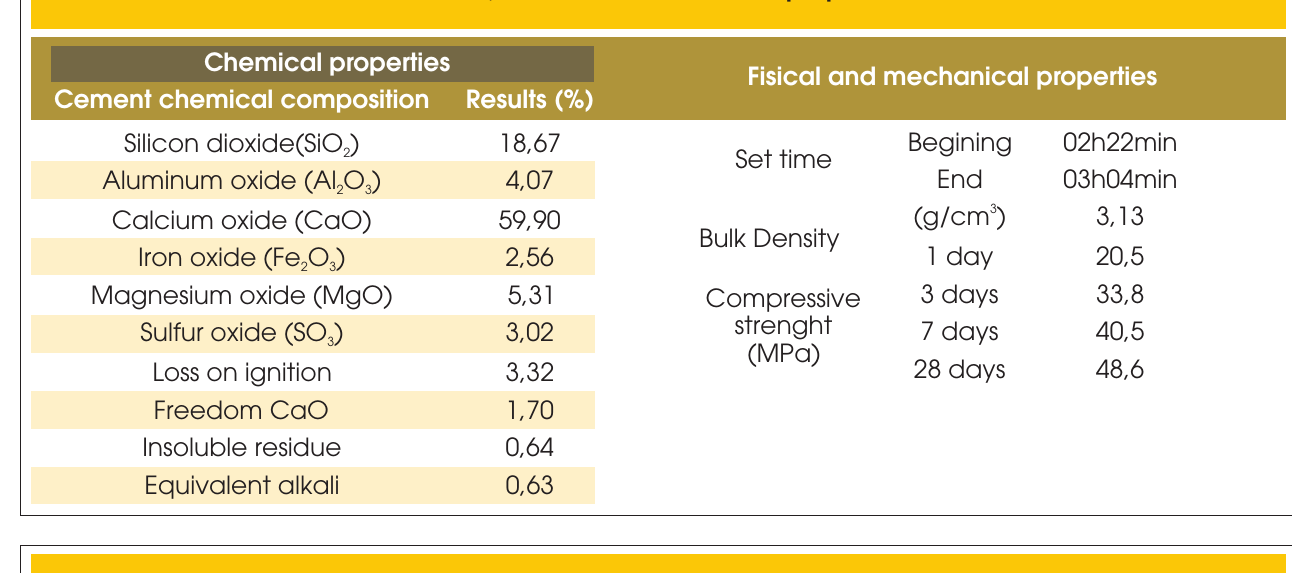
Table 6 – characteristics of the aggregates used in mixtures of